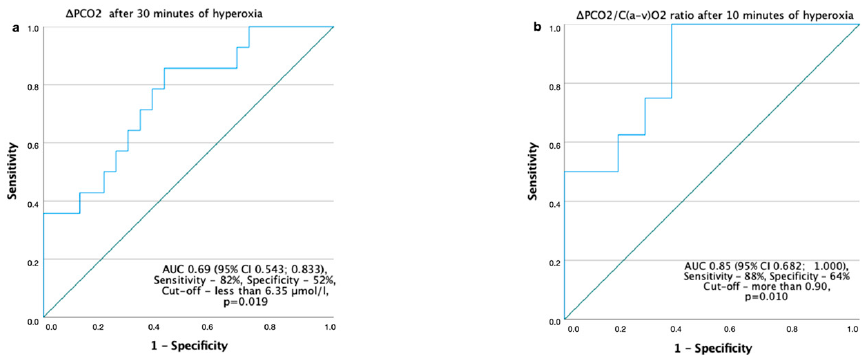
Figure 5. Prediction of complications after surgery by Δ PCO2 and C(a-v)O2 monitoring (ROC curves): ( a ) Δ PCO 2 after 30 min of hyperoxia for the prediction of ventricular fi brillation after CPB; AUC is 0.69 (95% con fi dence interval (CI) 0.543; 0.833), p = 0.019. The cuto ff is less than 6.35 µmol/mL, sensitivity — 82%, speci fi city — 52%; ( b ) Δ PCO2/C(a-v)O2 after 10 min of hyperoxia for prediction of postoperative complications in chronic heart failure patients. AUC is 0.85 (95% con fi - dence interval (CI) 0.682; 1.000), p = 0.010. The cuto ff is more than 0.90, sensitivity — 88%, speci fi c- ity — 64%.